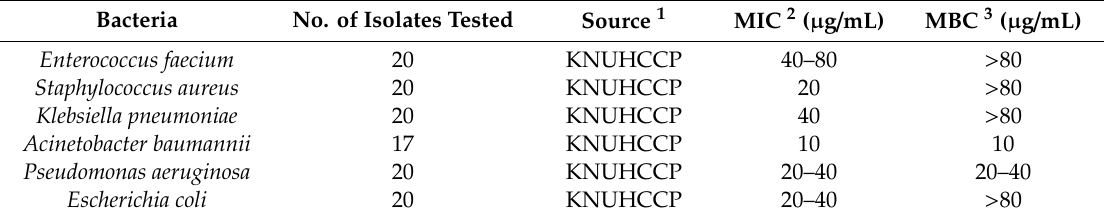
Table 2. Antimicrobial activity of LysSAP26 against drug-resistant clinical isolates.